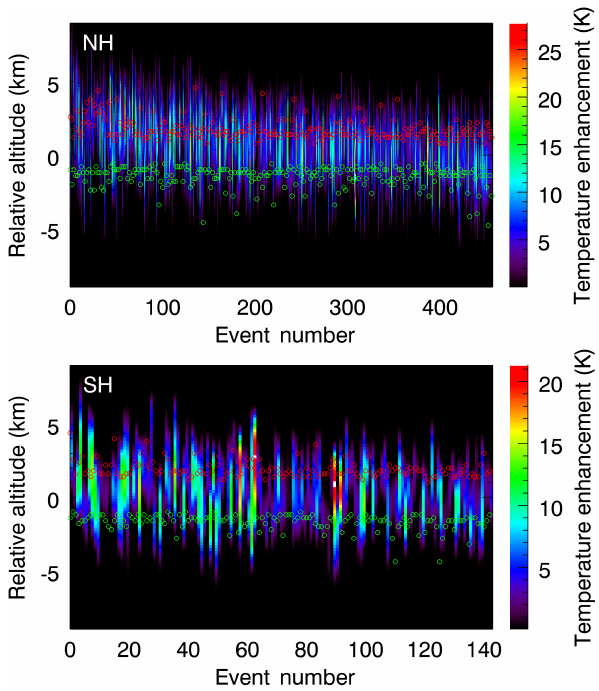
Figure 9. Temperature enhancement distributions for correspond- ing double-layer events which have maximum temperature en- hancements larger than 2K locating between their double peaks. Red and green circles denote the positions of upper and lower peaks respectively. All altitudes are aligned to their troughs.